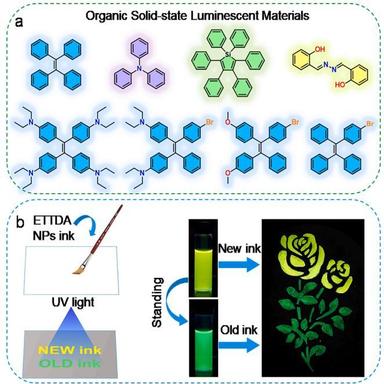
Successful manipulation of the ACPT process of other OSL materials by NPs suspension in this study (a). ETTDA NPs suspension can serve as anticounterfeiting ink (b), under UV irradiation, a figure painted with new NPs ink emits yellow light while the figure painted with old NPs ink emits green light. (For interpretation of the references to color in this figure legend, the reader is referred to the web version of this article.)